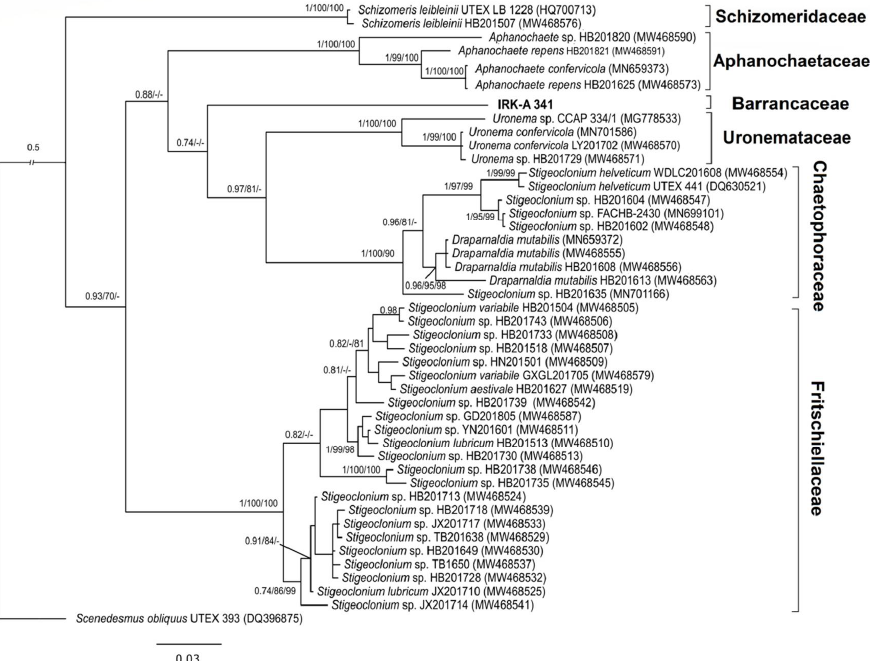
Figure 2. Plastid phylogenetic tree of the strain IRK–A 341 is based on the gene tufA . Bayesian tree is reconstructed from aligned 780 nucleotide sites. Bayesian probability support and bootstrap values (PP/ML/NJ) are given next to branch nodes. Values less than 70 (0.70) are not shown. The studied strain is marked with bold font. GenBank accession numbers are given in parentheses. The scale bar indicates the number of substitutions per site. Scenedesmus obliquus is shown as